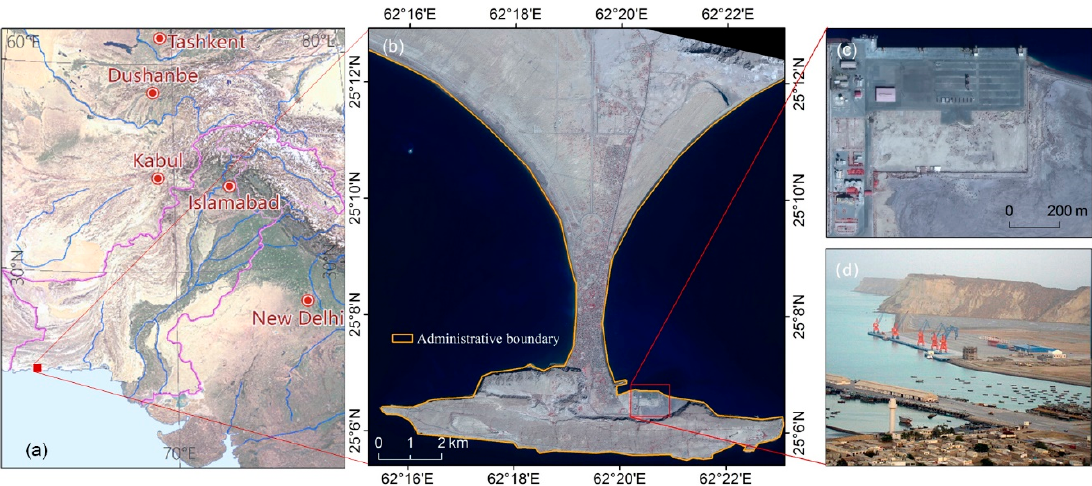
Figure 1. Study area. ( a ) Location of Gwadar in Pakistan; ( b ) GF (GaoFen, which means high spatial resolution in Chinese)-2 image of Gwadar in 2016 (covering approximately 90% of Gwadar); ( c ) and ( d ) are enlarged details and ground photo of the Gwadar port.